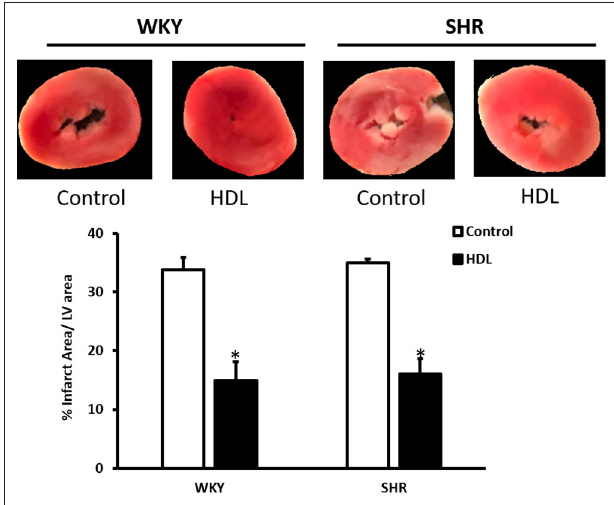
FIGURE 4 | HDL treatment reduces infarct size in WKY and SHR. WKY and SHR rats were treated with or without HDL and subjected to I/R injury ex-vivo . Infarct size was quantified in TTC stained sections. Data are expressed as means ± SEM, * P < 0.01, n = 3–5 per